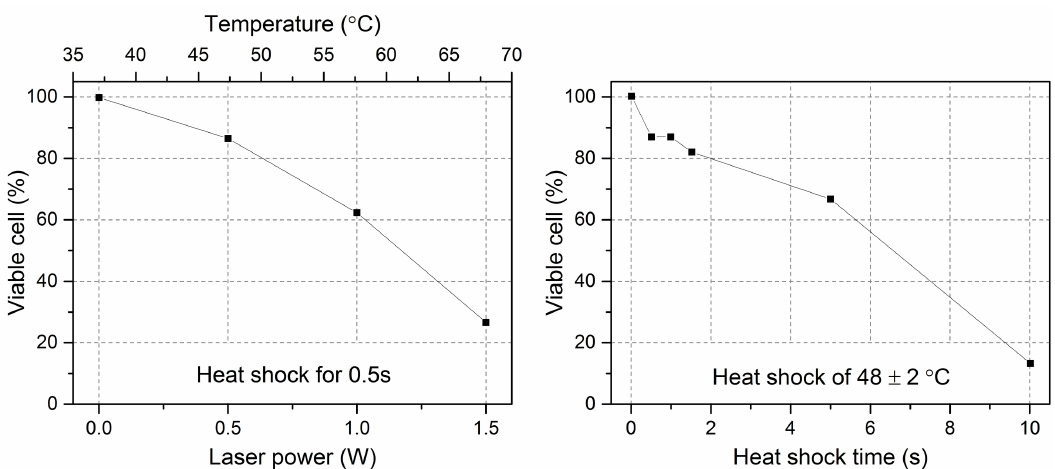
Figure 21. Heat shock impact on cell viability with different laser power (temperature) and time duration. The figure was realized exploiting the data reported in Reference